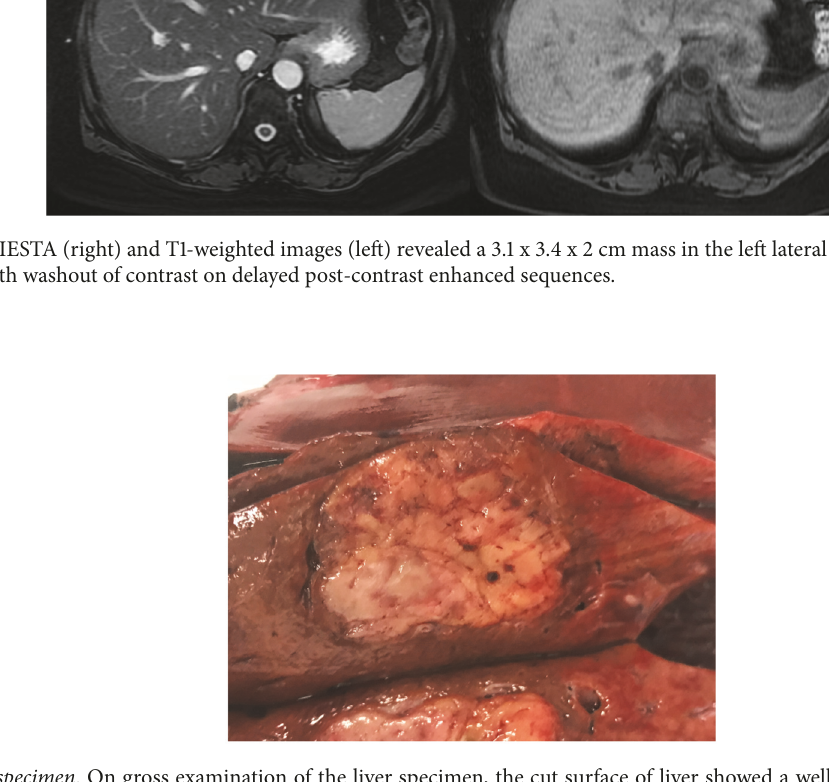
Figure 2: Gross specimen . On gross examination of the liver specimen, the cut surface of liver showed a well-demarcated, glistening, tan- yellow, lobular mass, measuring 3.0 x 2.5 x 2.0 cm. Final surgical pathology confirmed the diagnosis of epithelioid angiomyolipoma with no evidence of malignancy and 2.2 cm surgical